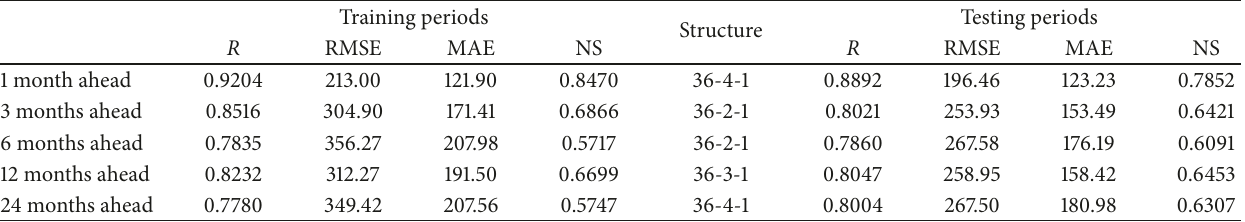
Table 6: Performance statistics of the ANN model with three input variables (runoff, precipitation, and air temperature) during the training and testing periods for 1-, 6-, 12-, and 24-month-ahead runoff forecasting in the